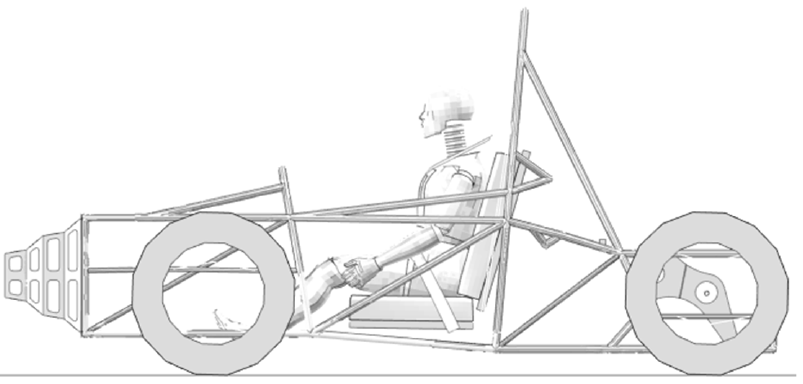
Figure 6. The initial reference position.